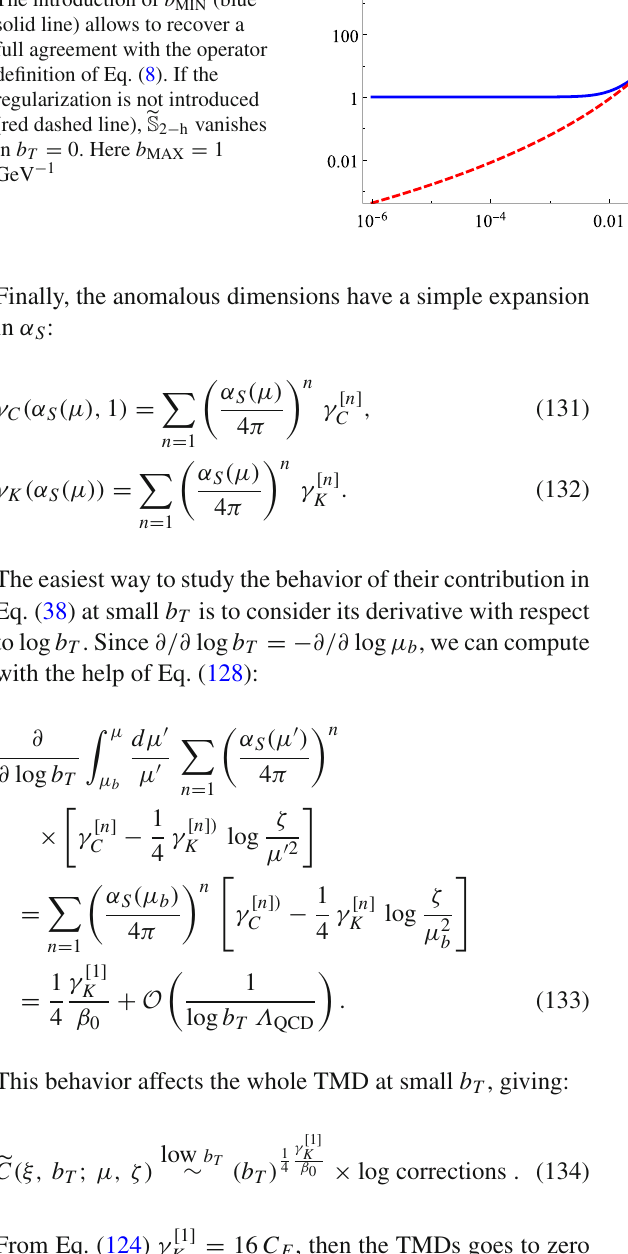
Fig. 13 Leading Log (LL) Fourier Transformed 2-h Soft Factor in the small b T region. The introduction of b MIN (blue solid line) allows to recover a full agreement with the operator definition of Eq. (8). If the regularization is not introduced (red dashed line), (cid:7) S 2 − h vanishes in b T = 0. Here b MAX = 1 GeV −